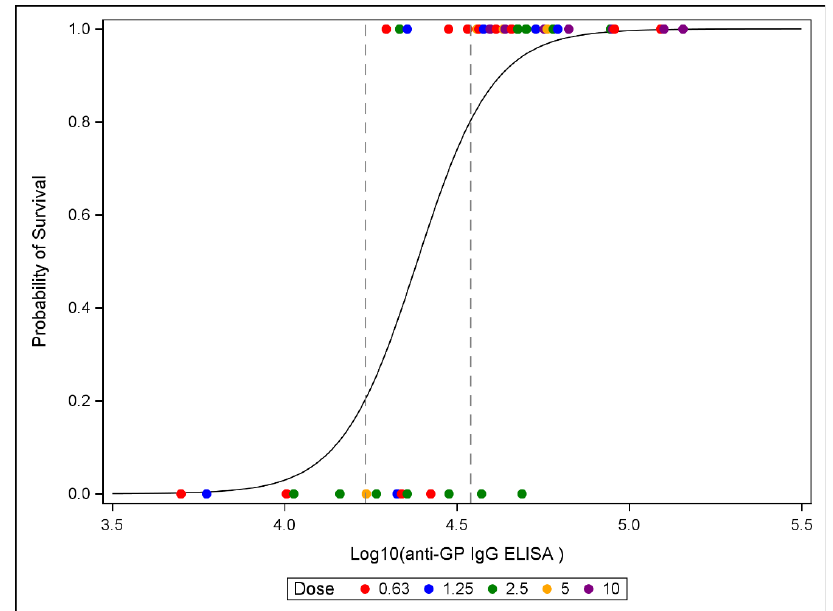
Figure 2. Estimated logistic model with survival data overlaid. Dashed lines represent ED 20 and ED 80 .